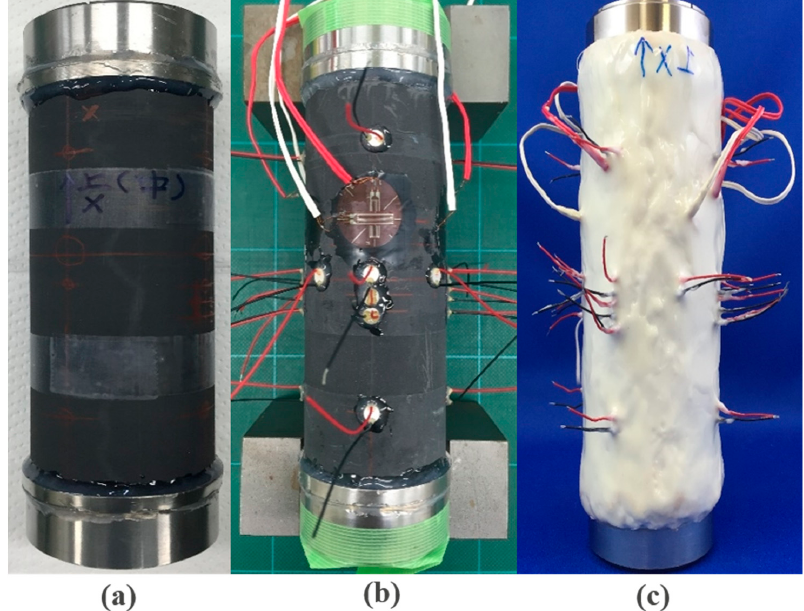
Figure 8. The core preparation process. Figure ( a ) is the original experimental core, ( b ) is the core after the installation of PZT sensor, strain gauge and ( c ) is encapsulated core with adhesive.